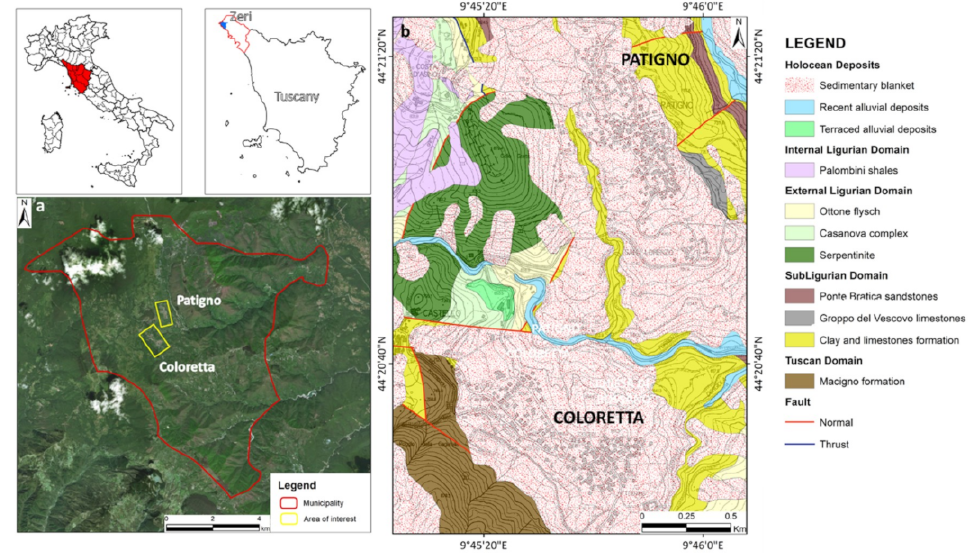
Figure 1. Area of Interest ( a ) and geology divided in geological domains and formations ( b